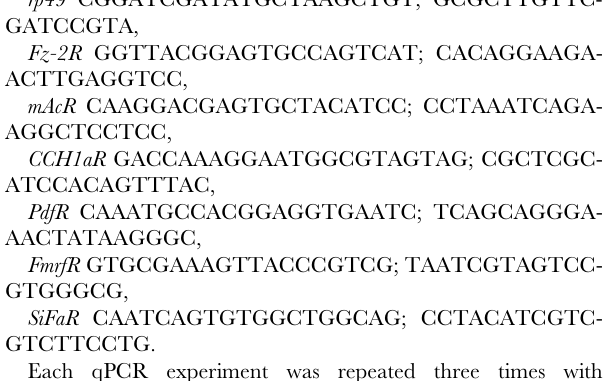
Figure S2 Genetic validation of GPCRs as IP 3 /Ca 2 + linked by pan-neuronal expression of AcGq and dSTIM + . The grey bars for each RNAi strain represent percentage flight time of adults with pan-neuronal knockdown of the indicated GPCR. The blue and green bars represent the percentage flight time by